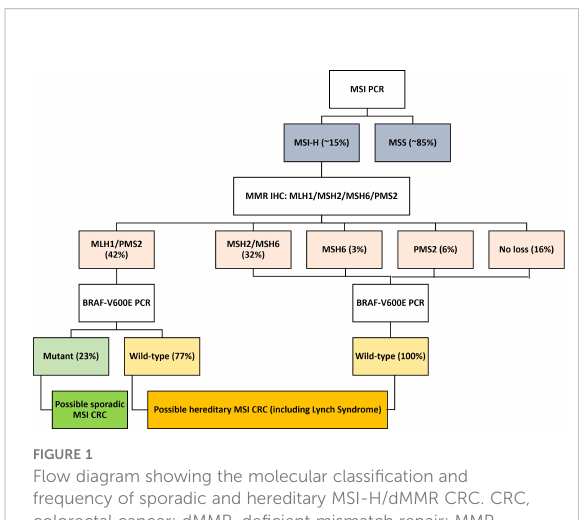
FIGURE 1 Flow diagram showing the molecular classi fi cation and frequency of sporadic and hereditary MSI-H/dMMR CRC. CRC, colorectal cancer; dMMR, de fi cient mismatch repair; MMR, mismatch repair; MSI-H, microsatellite